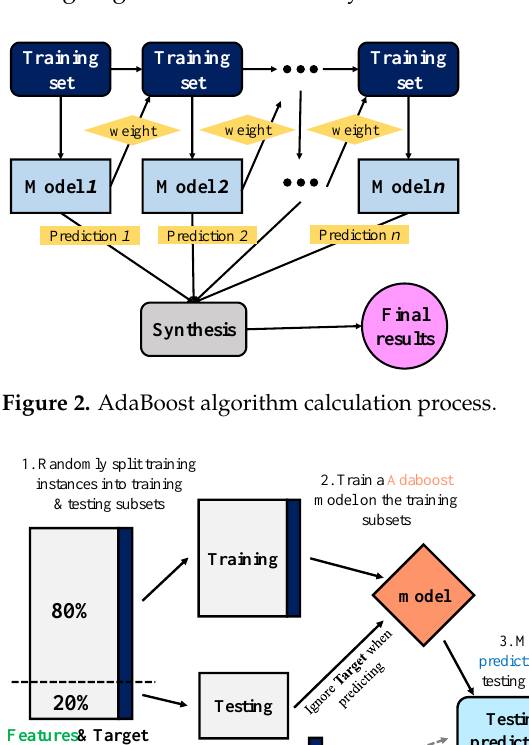
Figure 2. AdaBoost algorithm calculation process.